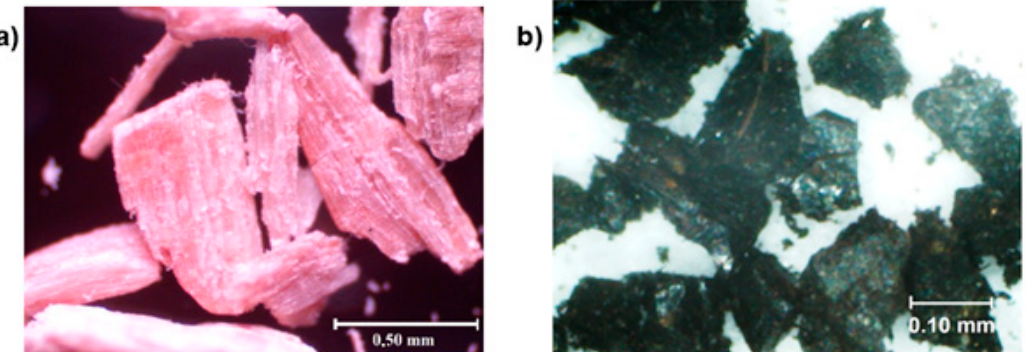
Figure 4. The microscopic photograph of fuel: ( a ) biomass ( b ) hard coal.